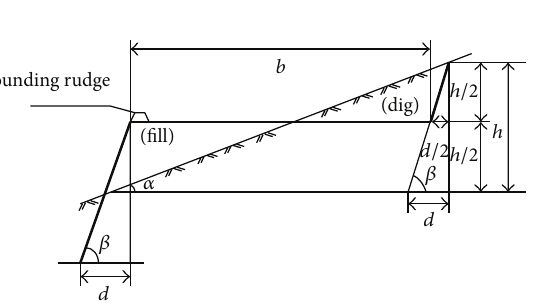
Figure 1: Slope-to-terrace sectional